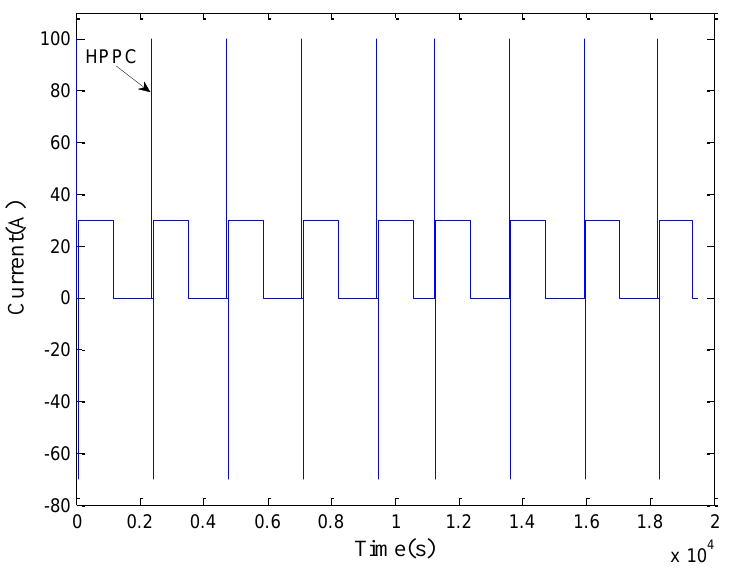
Figure 9. A testing cycle for evaluating the validity of the battery